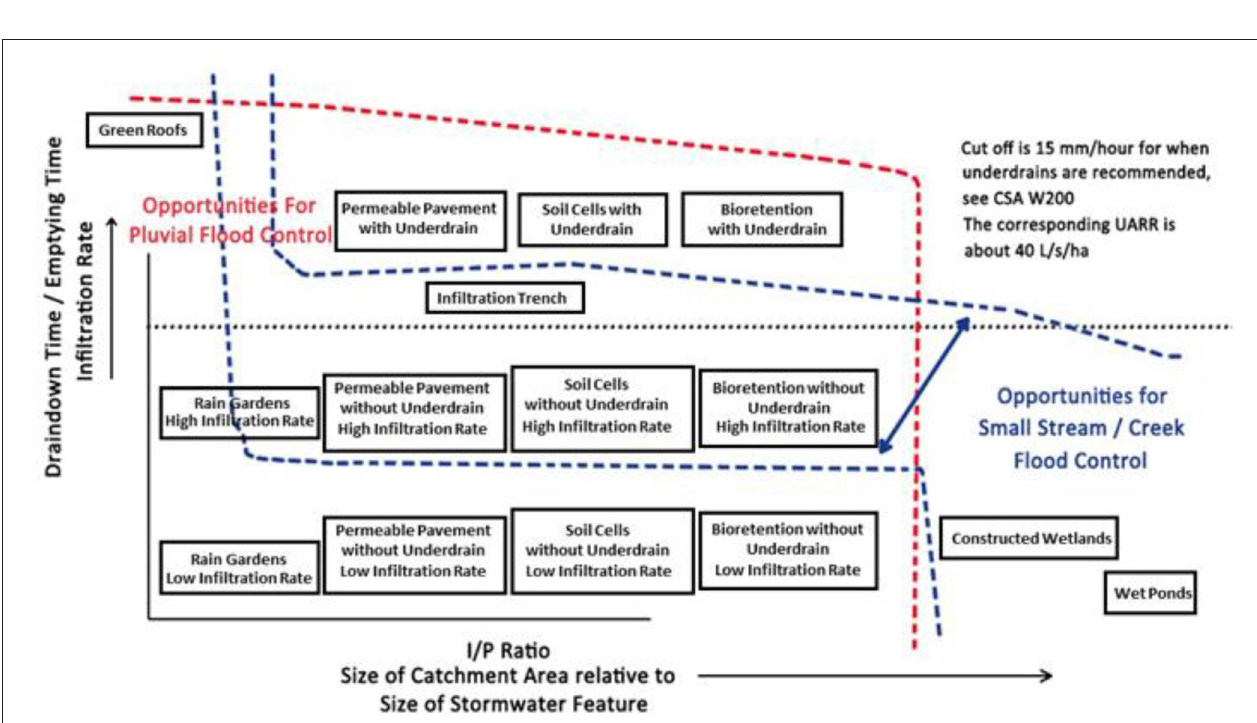
FIGURE 7 | LID and other measures as function of I/P Ratio and Drain-down/Emptying Time.